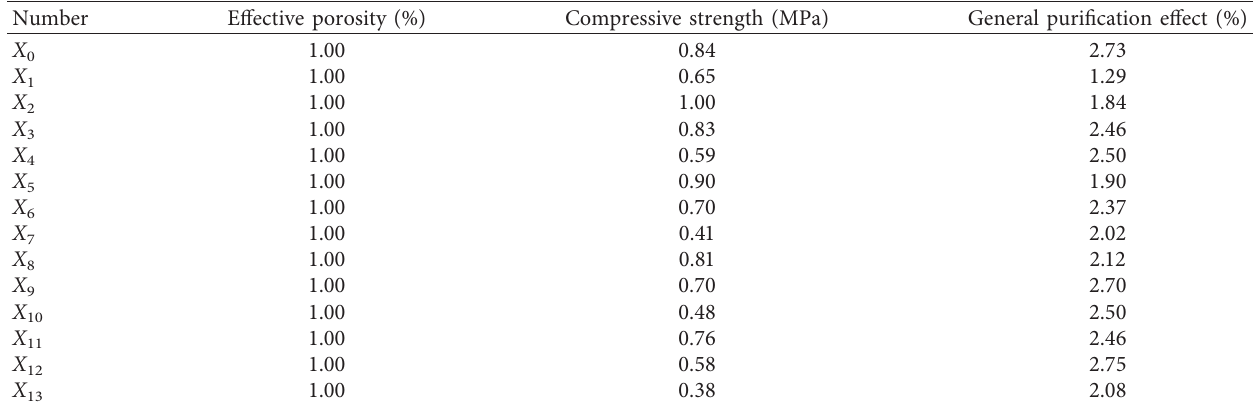
Table 8: Dimensionless results of gray correlation analysis.